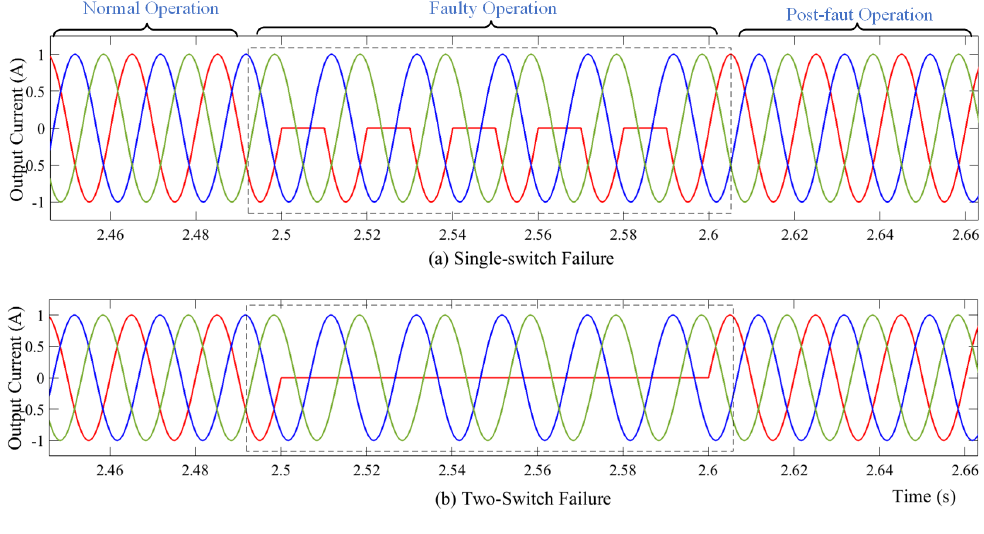
Figure 10. Simulation waveform of output currents during fault-tolerant operation: ( a ) Single-switch failure, ( b ) Two-switch failure.